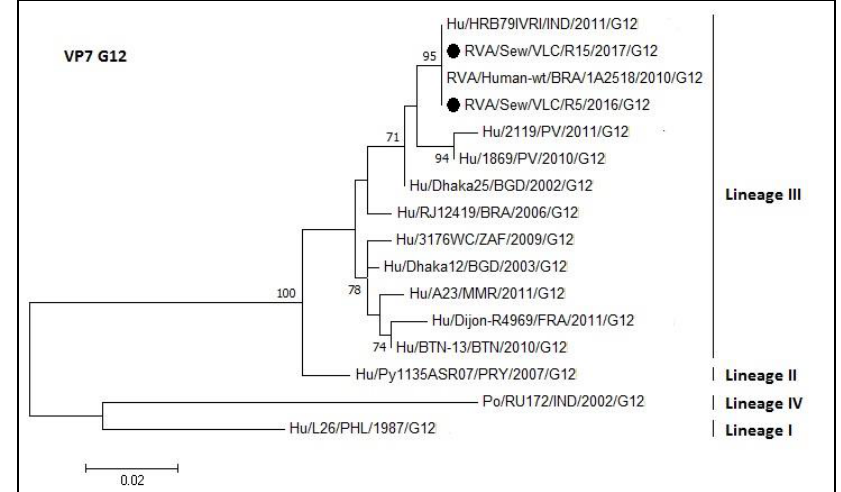
Figure 9. Molecular phylogenetic analysis of G12 rotavirus (VP7 gene). The evolutionary history was inferred by using the Maximum Likelihood method based on the Tamura 3-parameter model [43] with a bootstrap of 1000 replicates. The tree is drawn to scale, the branch lengths measure the number of substitutions per site. The analysis involved 16 nucleotide sequences. There was a total of 378 positions in the final dataset including nucleotides from 584 to 926.